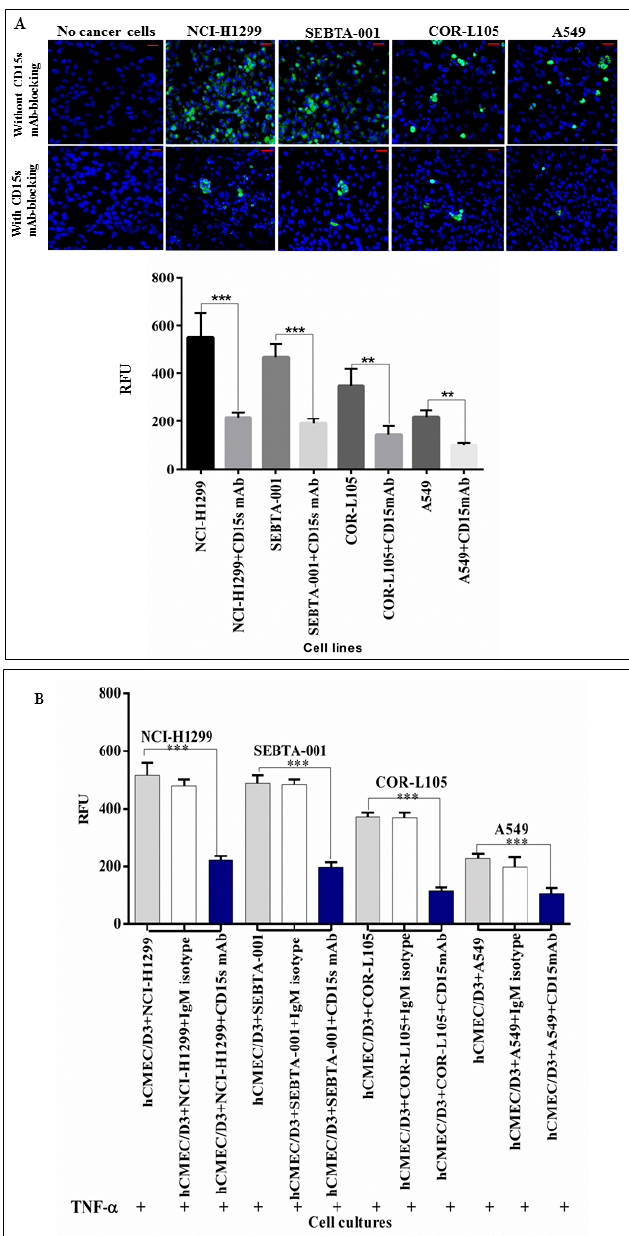
Figure 3. ( A ) CD15s immunoblocking reduced the adhesion of lung cancer cells under static conditions. Confocal images (top panel) showing adhesion of green fluorescently labelled NSCLCs on a brain endothelial cell monolayer (blue) and semi-quantitative analysis of confocal images (lower panel) showed a significant decrease in adhesion ability of NSCLC cells to adhere to hCMEC/D3 cells. n = 3, *** p < 0.001 and ** p < 0.01. Scale bar = 20 µm. Data is expressed as ±SE. We used the same concentration of TNF- α as optimised in a previous study [5] to activate the expression of CD62E on brain endothelial cells. Brain endothelial cells (hCMEC/D3) were exposed to 25 pg/mL of TNF- α for 18 h and levels of CD62E were detected using flow cytometry (Data not shown); ( B ) blocking with CD15s mAb significantly decreased the adhesion of NSCLC to brain endothelium. Quantitative adhesion assay of human primary and metastatic lung cancer (NSCLC) cells blocked with CD15s mAb (blue bar), non-specific isotype IgM (white bar) to assess the efficiency and specificity of CD15s mAb-blocking efficiency and NSCLC cells on a monolayer of hCMEC/D3 (grey bar) as a negative control. n = 3, *** p < 0.001. Data is expressed as ±SE.